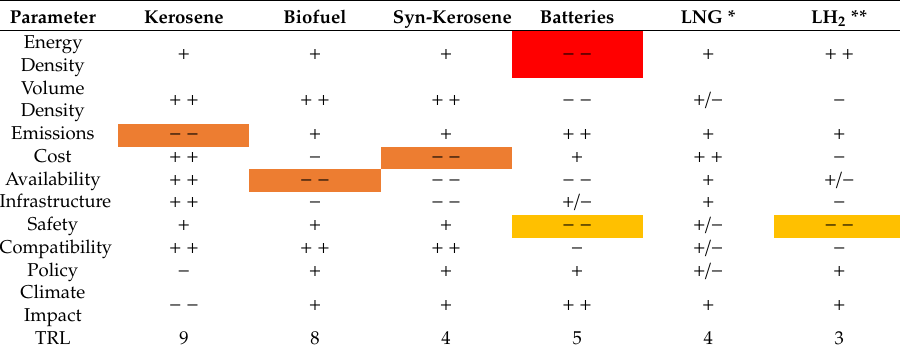
Table 2. Simplistic comparison of di ff erent energy sources. Parameter Kerosene Biofuel Syn-Kerosene Batteries